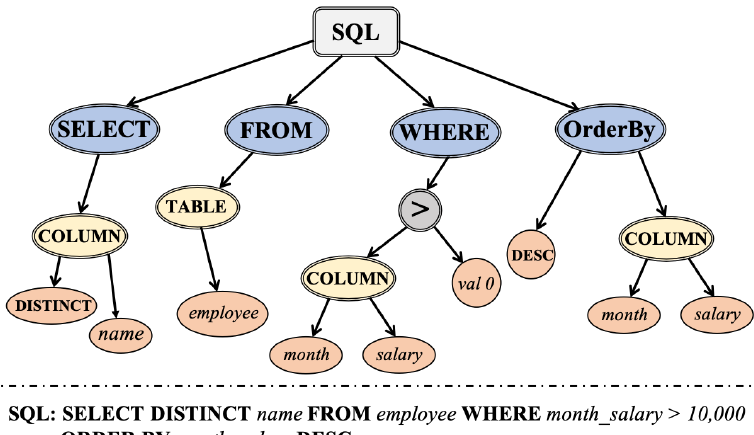
Figure 2. An example of the constructed SQL